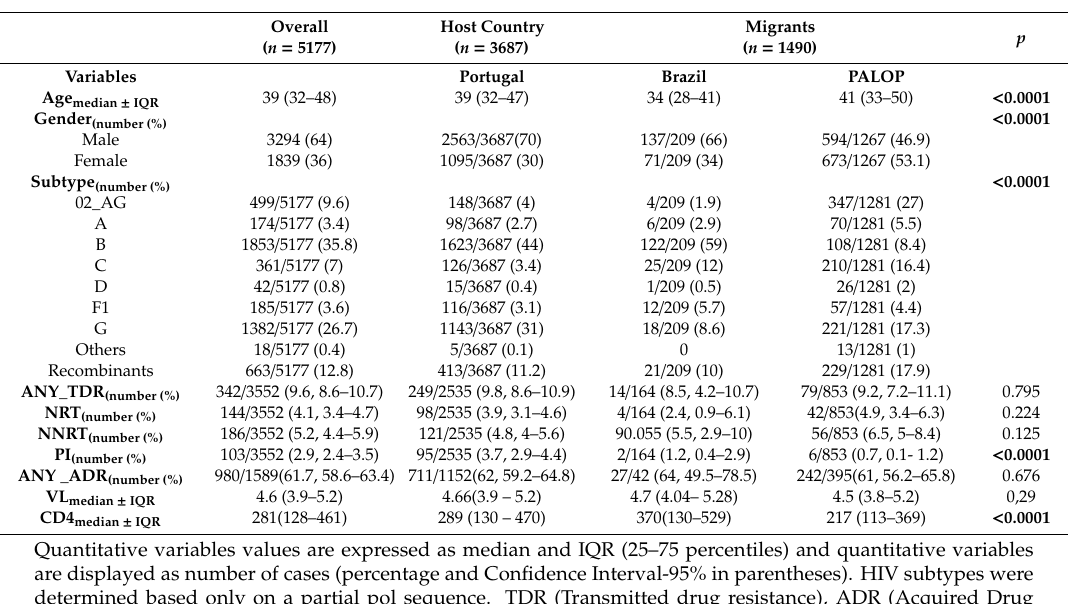
Table 2. Characteristics of migrants versus Portuguese population followed up in Portugal, 2001–2017.